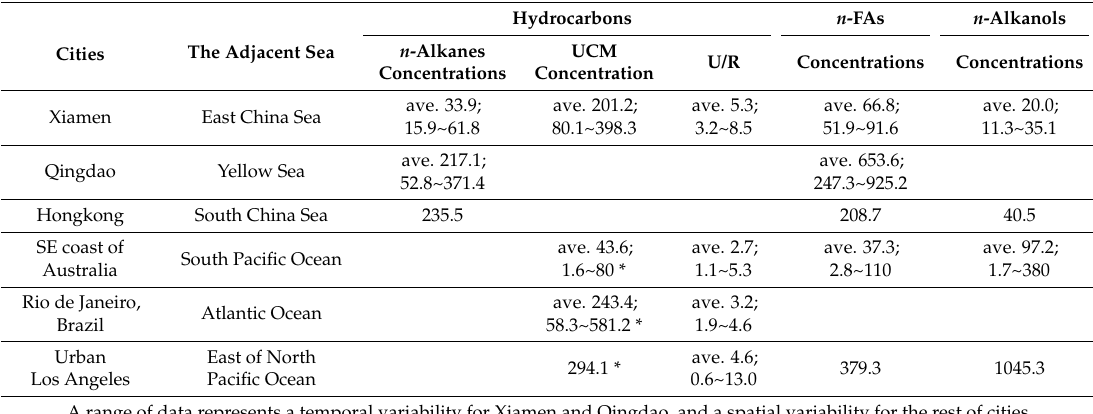
Table 2. Comparison of three lipids data among different coastal